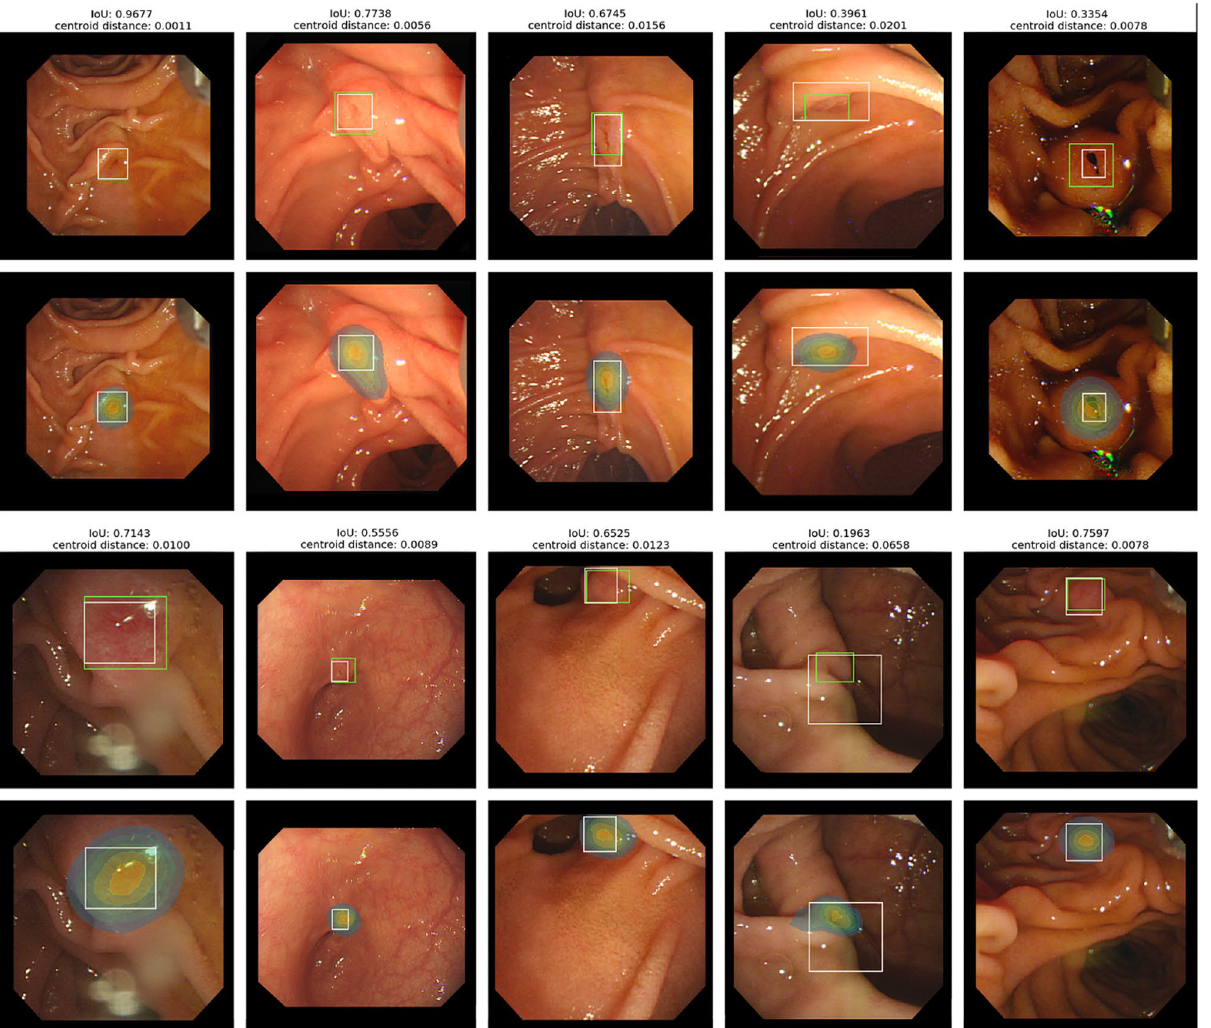
Figure 2. Examples of the model prediction and GT label. A model prediction is present in two different ways, the green bbox (upper) and heatmap visualization (lower). In both cases, the white bbox indicates the GT label. For each prediction, IoU and centroid distance are written above. Heatmap results show that the predicted masks from our model accurately match AOVs in size and shape, even ones with IoU around 30%.